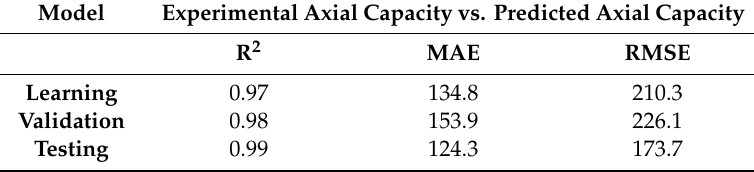
Figure 4. Expression tree for the GEP model. Table 4. GEP model execution